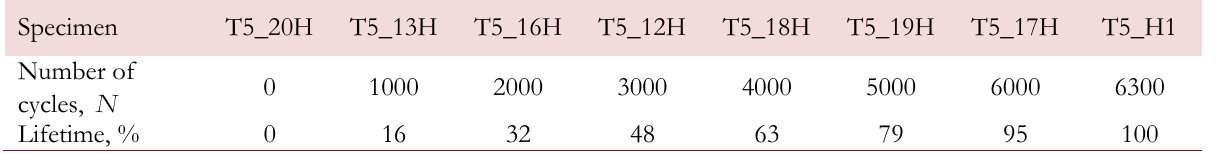
Table 1: Nomenclature of T5-H1 specimens and fatigue loading program.